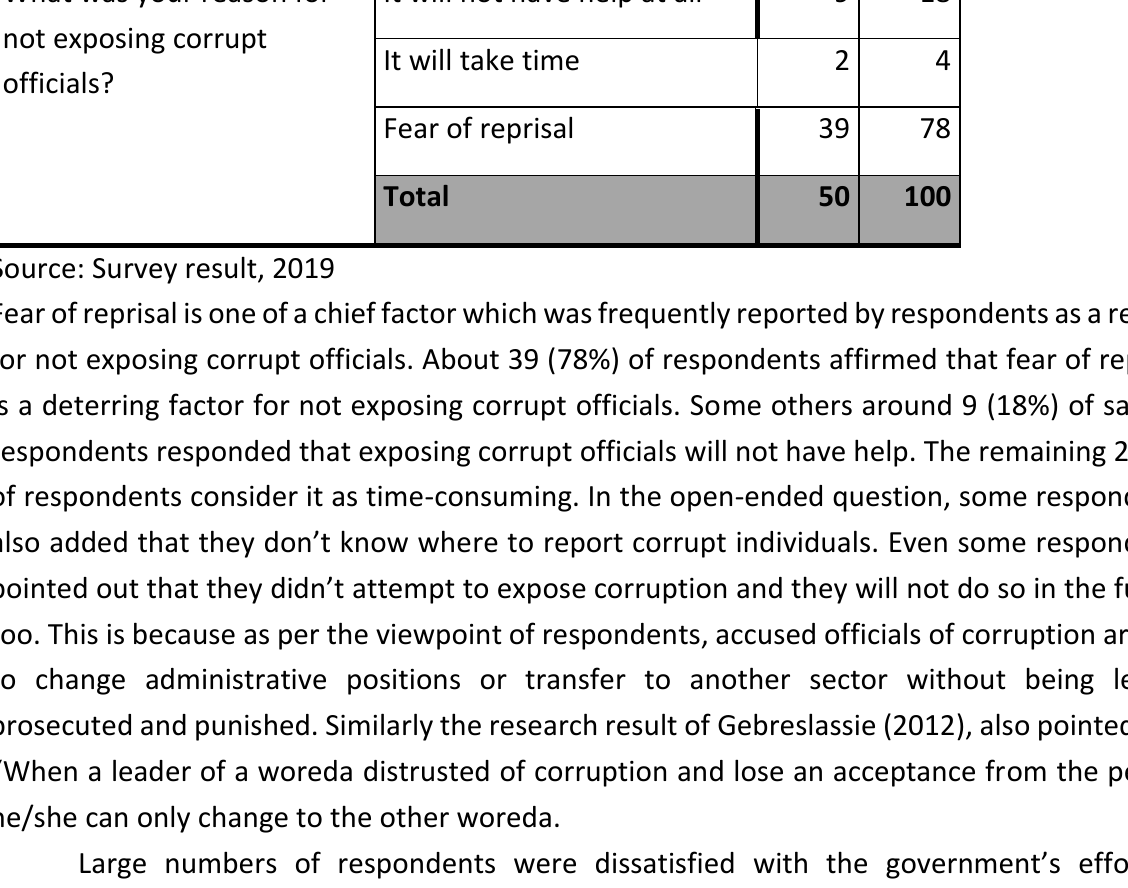
Table 19: Factors for not exposing corrupt officials Item F % What was your reason for not exposing corrupt